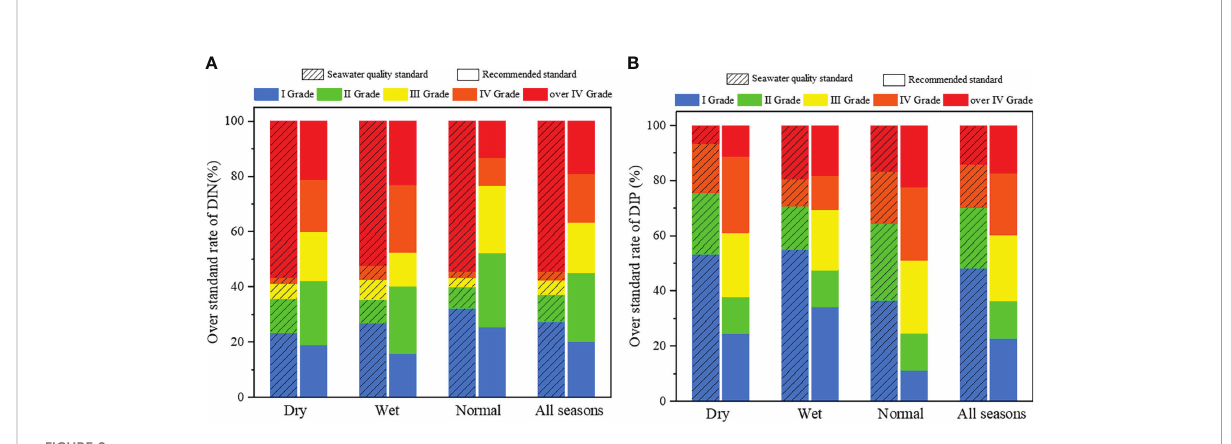
FIGURE 8 Seawater quality standard and the recommended standard assessment DIN (A) and DIP (B) .